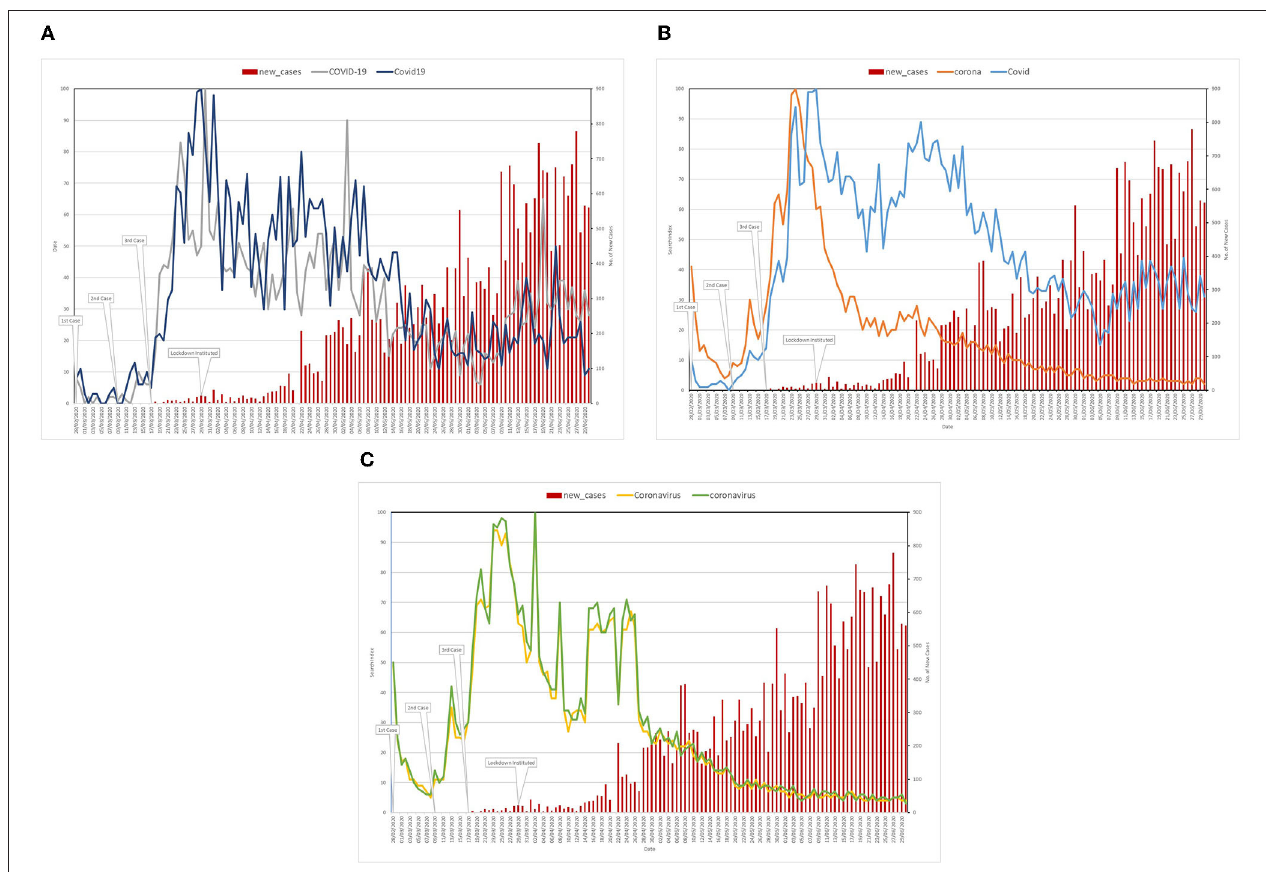
FIGURE 1 | Trend of public attention on COVID-19 related search terms and new COVID-19 cases (A) Search terms: Coronavirus and coronavirus (B) Search terms: corona and Covid, and (C) Search terms: COVID-19 and